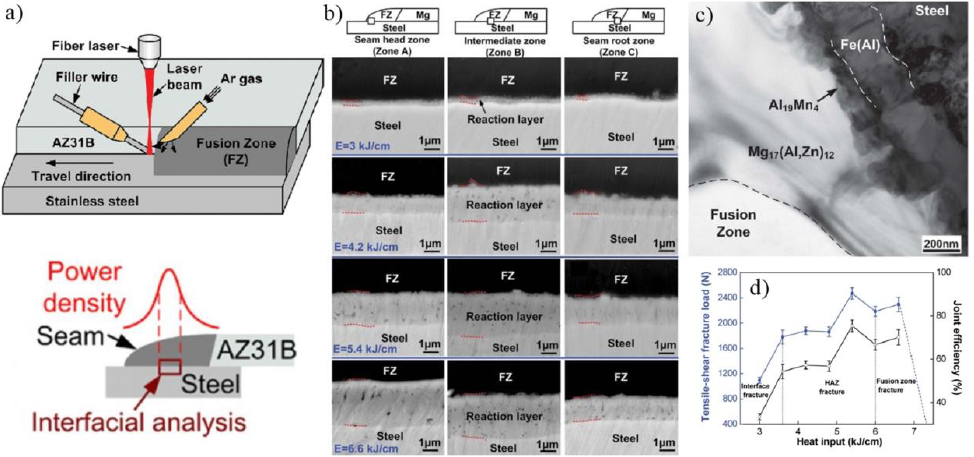
Figure 15. Laser welding-brazing with filler wire [47] ( a ) schematic diagram of the welding process; ( b ) interfacial microstructure at different heat inputs; ( c ) TEM bright field image at 5.4 kJ/cm heat input; ( d ) tensile-shear fracture load at different heat inputs.